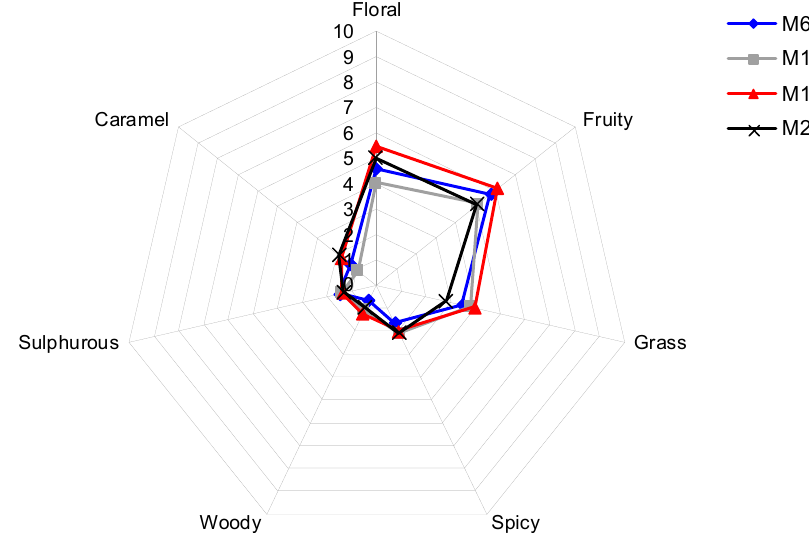
Figure 2. Aroma profile of Treixadura wines as affected by storage time in the bottle. Data are averages for the 8 wine samples considered in the current study. M6, M12, M18, and M24 indicate 6, 12, 18, and 24 months after bottling.